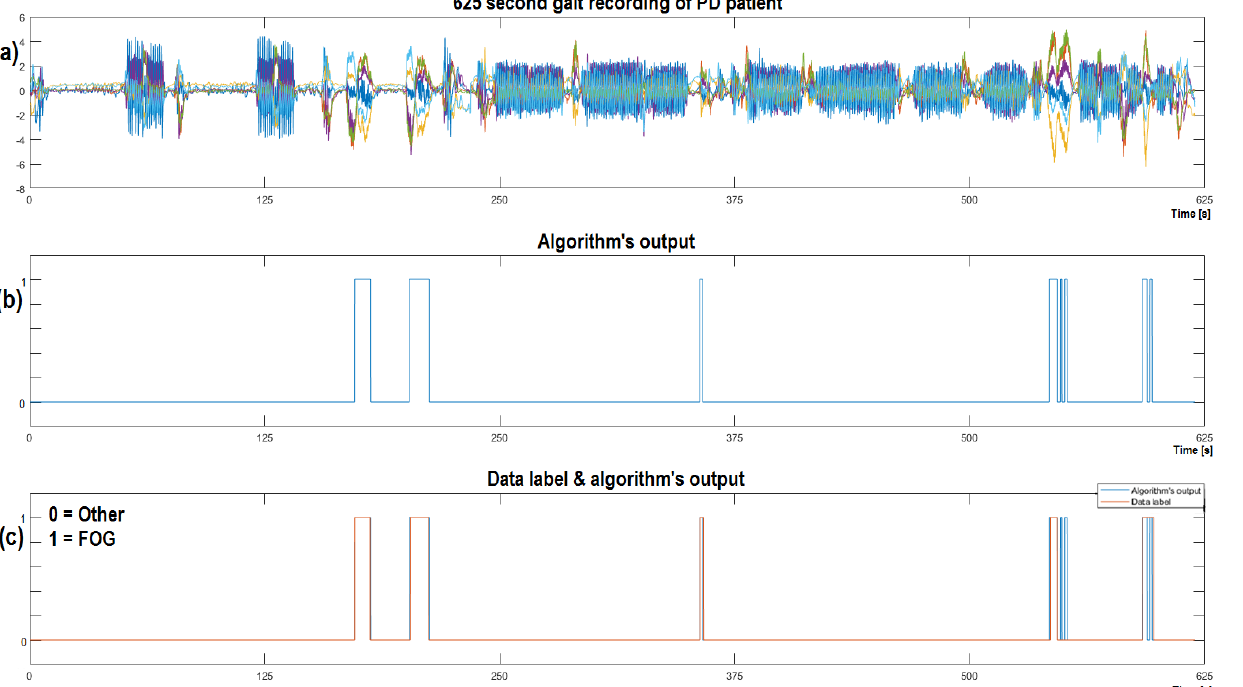
Table 10. Evaluation metrics for four classifiers.